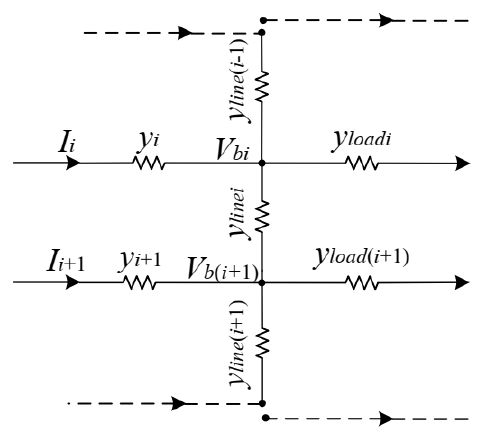
Figure 3. Network